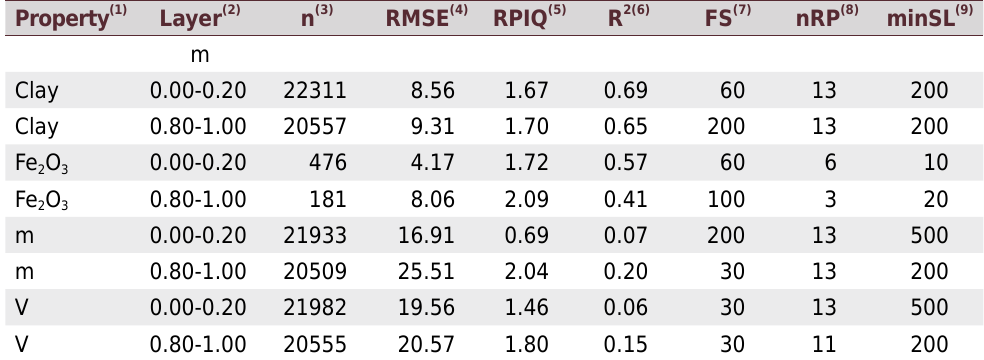
Table 3. Performance evaluation of soil attributes prediction using out-of-the-bag validation Property (1)